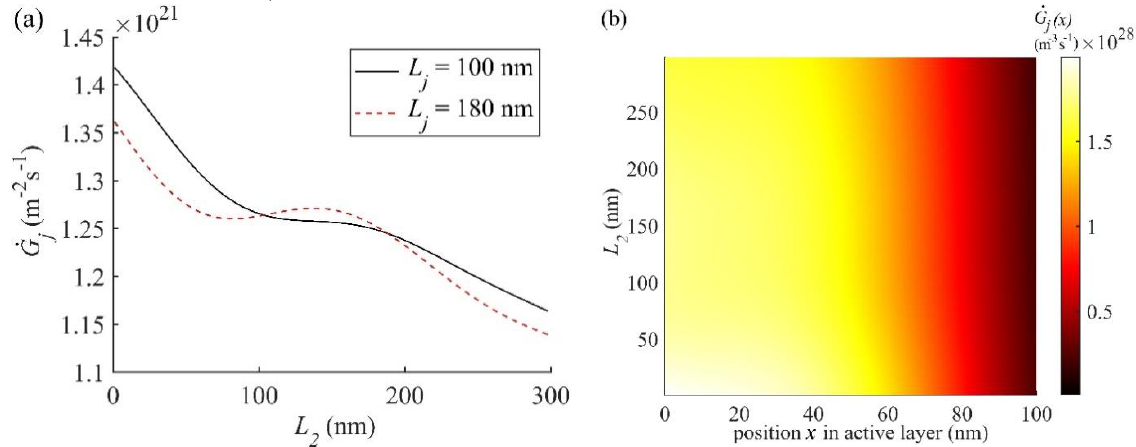
Figure 7. ( a ) 𝐺̇ 𝑗 is plotted as function of the thickness L 2 of layer 2 (PEDOT:PSS) in OSC2 for two active layer thicknesses 𝐿 𝑗 = 100 nm and 180 nm. ( b ) Contour plots of 𝐺̇ 𝑗 (𝑥) as a function of thickness L 2 of layer 2 and position x within the active layer of OSC2 at the optimal thickness 𝐿 𝑗 = 100 nm of the active layer.